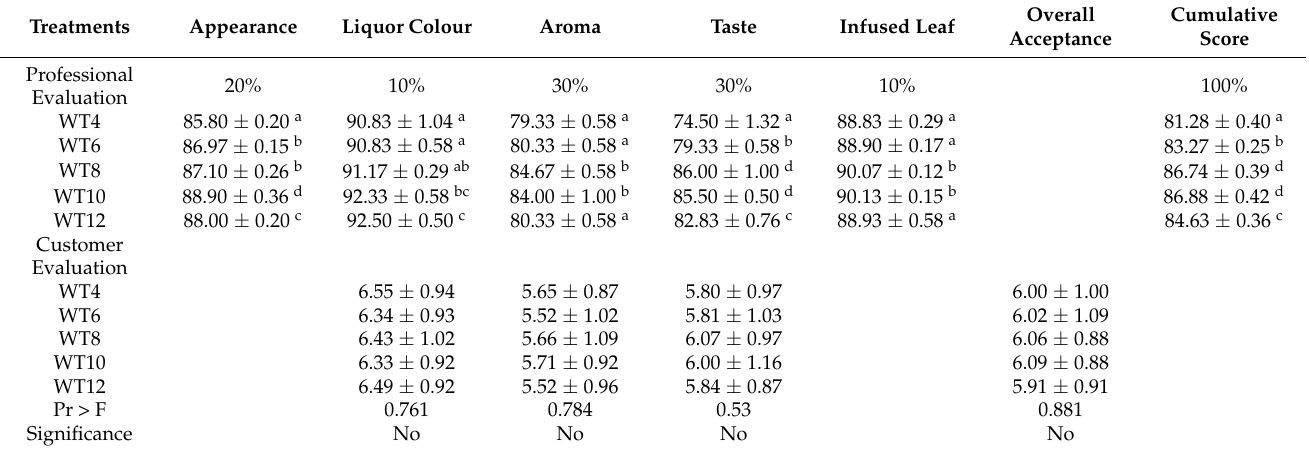
Table 1. Professional and customer sensory evaluations of black tea with different withering time.